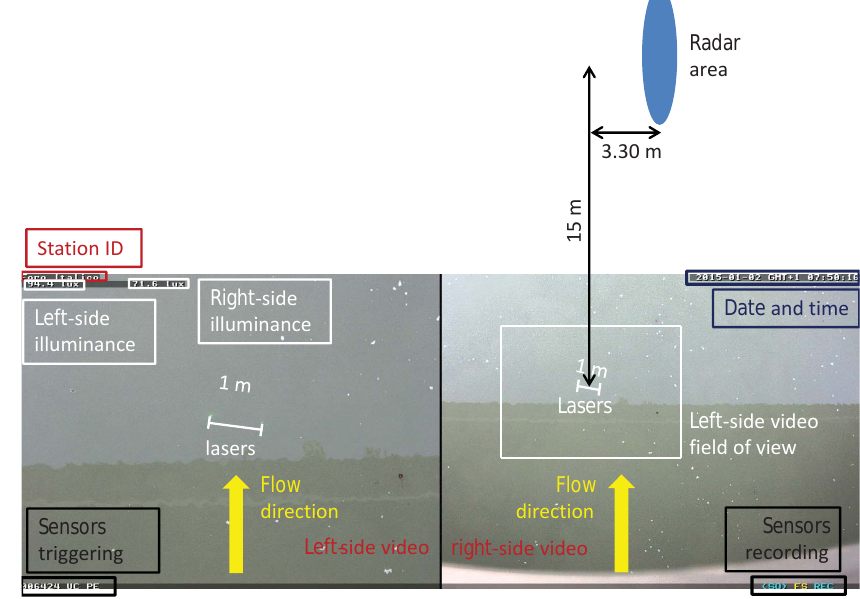
Figure 3. Representative experimental video frame captured from the gauge-cam station. Left: field of view recorded with the left-side optical sensor; right: with the right-side optical sensor. On the video frame captured with the right-side optical sensor, the field of view of the left-side video and the radar-focused area are also